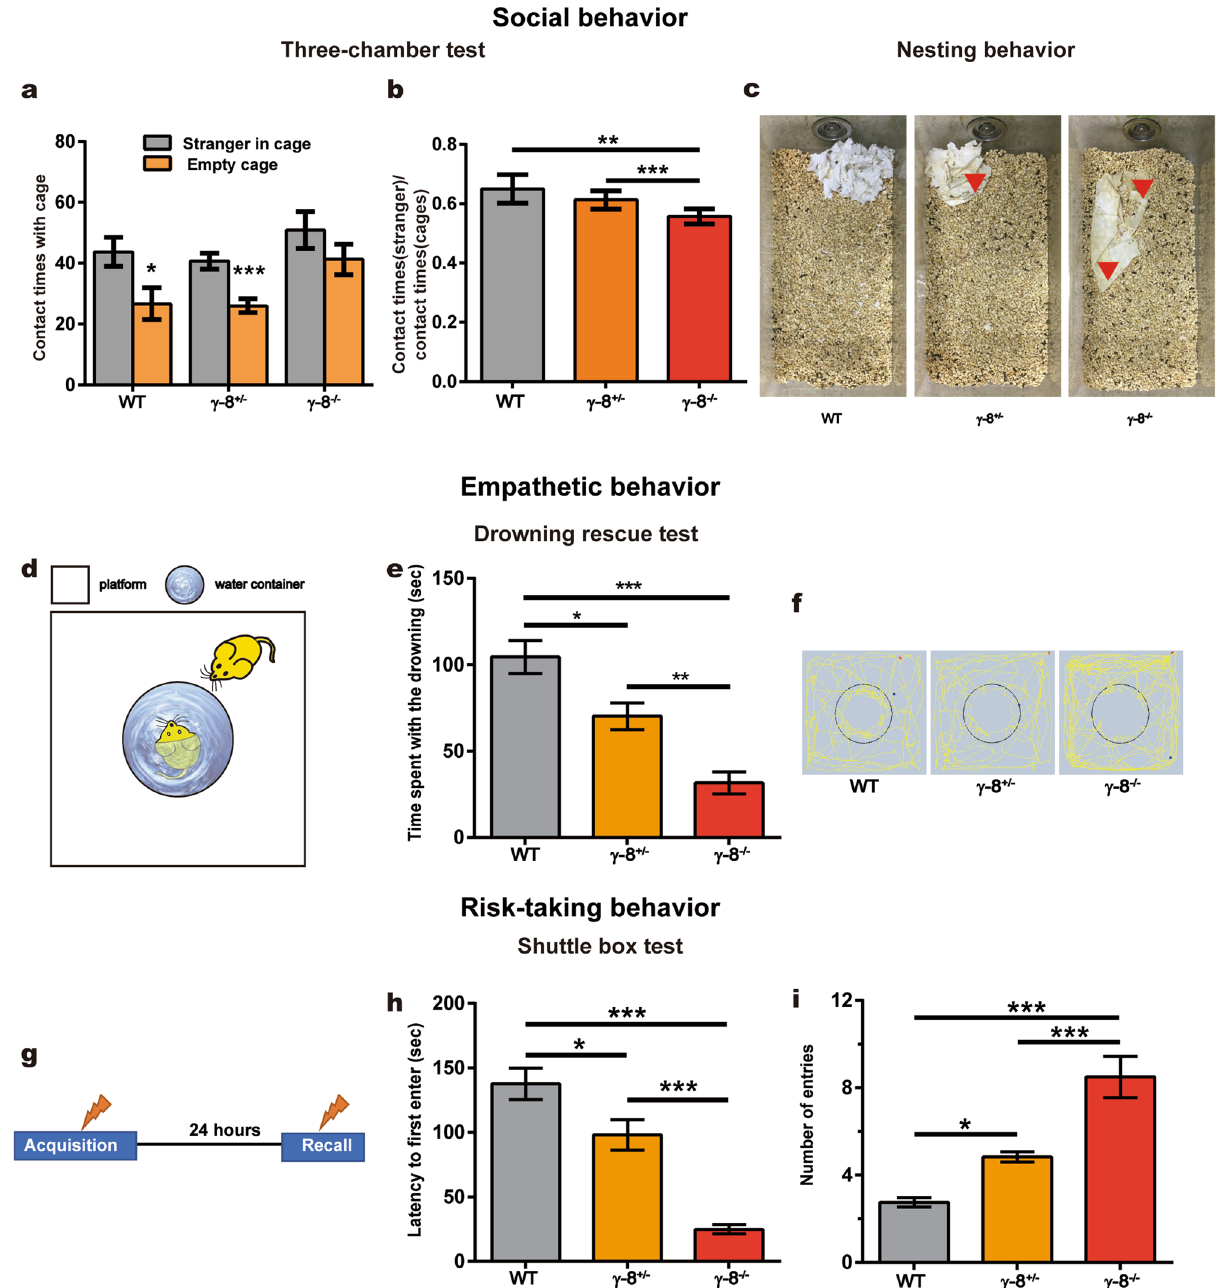
Figure 4. Impaired prosocial behavior and lesson-learning ability in TARP γ-8 knockout mice. ( a , b ) Three- chamber tests. ( a ) Contact times with the empty cage or stranger cage during the 10 min period and ( b ) stranger/total contacts of the WT (n = 11), TARP γ-8 +/− (n = 12) and TARP γ-8 −/− (n = 11) mice. Data represent the mean ± s.e.m. Independent-sample t -test used in ( a ), one-way ANOVA used in ( b ), * p < 0.05, ** p < 0.01, *** p < 0.001. ( c ) Representative photos of mouse cages taken after four mice of same genotype housed in one cage for 7 days without a change of bedding. The paper was the nest where the animals slept. The arrows indicate yellow stains on the paper from the urine of TARP γ-8 +/− and TARP γ-8 −/− mice while no yellow stains on the nest were observed in the cages of the WT mice. ( d – f ) Empathetic behavior tests. ( d ) Schematic of the drowning rescue test. The mice in platform were the cage mate of mice in the water container. ( e ) Time spent with the drowning cage mate during the 5 min period and ( f ) movement traces of the WT, TARP γ-8 +/− and TARP γ-8 −/− mice (n = 12 for each) in the drowning rescue test. Red dots: experiment start position, Blue dots: experiment end position, Yellow line: movement traces, the black circle: 4 cm from the edge of the container. ( g – i ) Risk-taking behavior test. ( g ) Schematic of the shuttle box test. After receiving a plantar shock (defined as acquisition), mice were fed freely for 6 h and then fasted for 18 h. The mice were tested for 180 s. Lightning bolts: Bottom shock. ( h ) initial latency to enter and ( i ) total number of entries (n = 12 for each). Data represent the mean ± s.e.m. one-way ANOVA, * p < 0.05, ** p < 0.01, *** p <